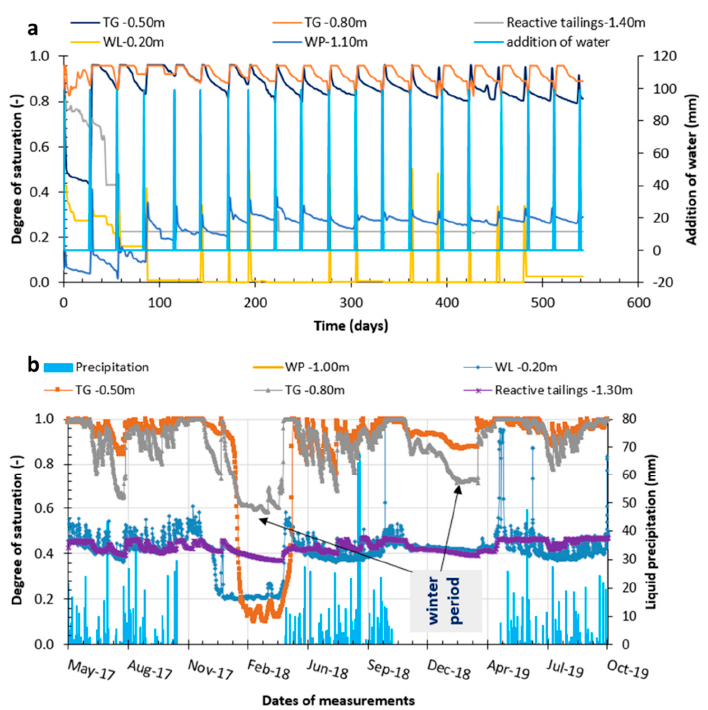
Figure 6 . Hydrogeological behavior: ( a ) Laboratory column test and ( b ) field cell test. Figure 6. Hydrogeological behavior: ( a ) Laboratory column test and ( b ) field cell